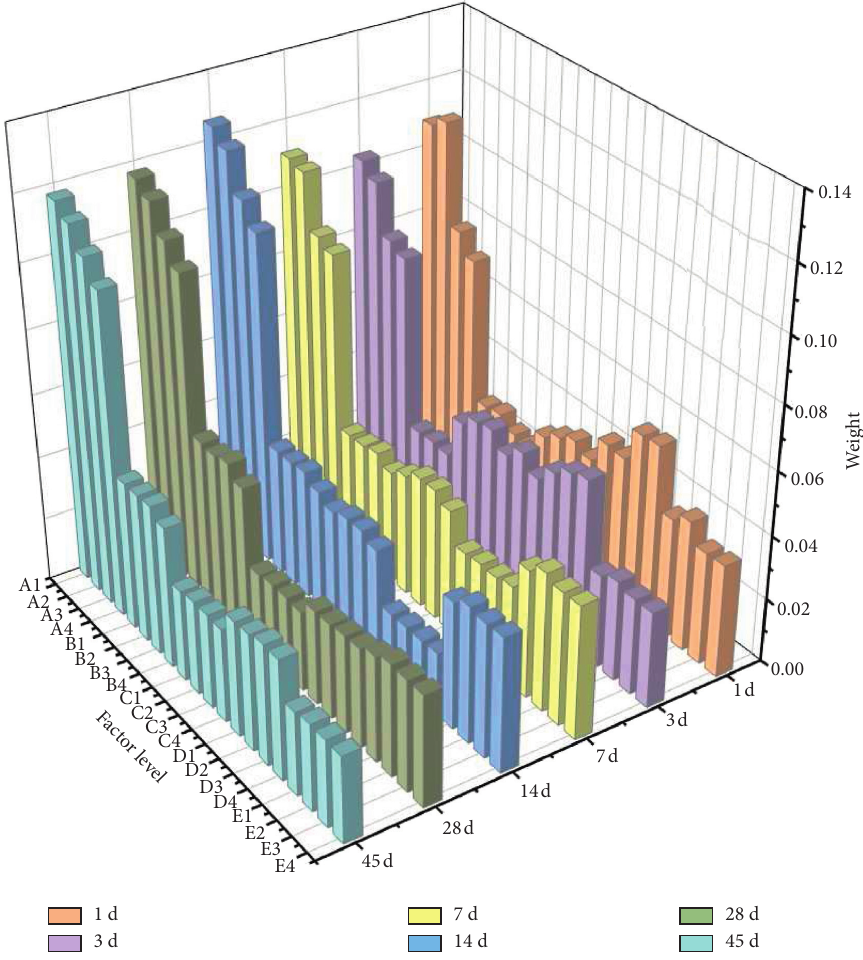
Figure 10: Influence weight of each factor level on the test